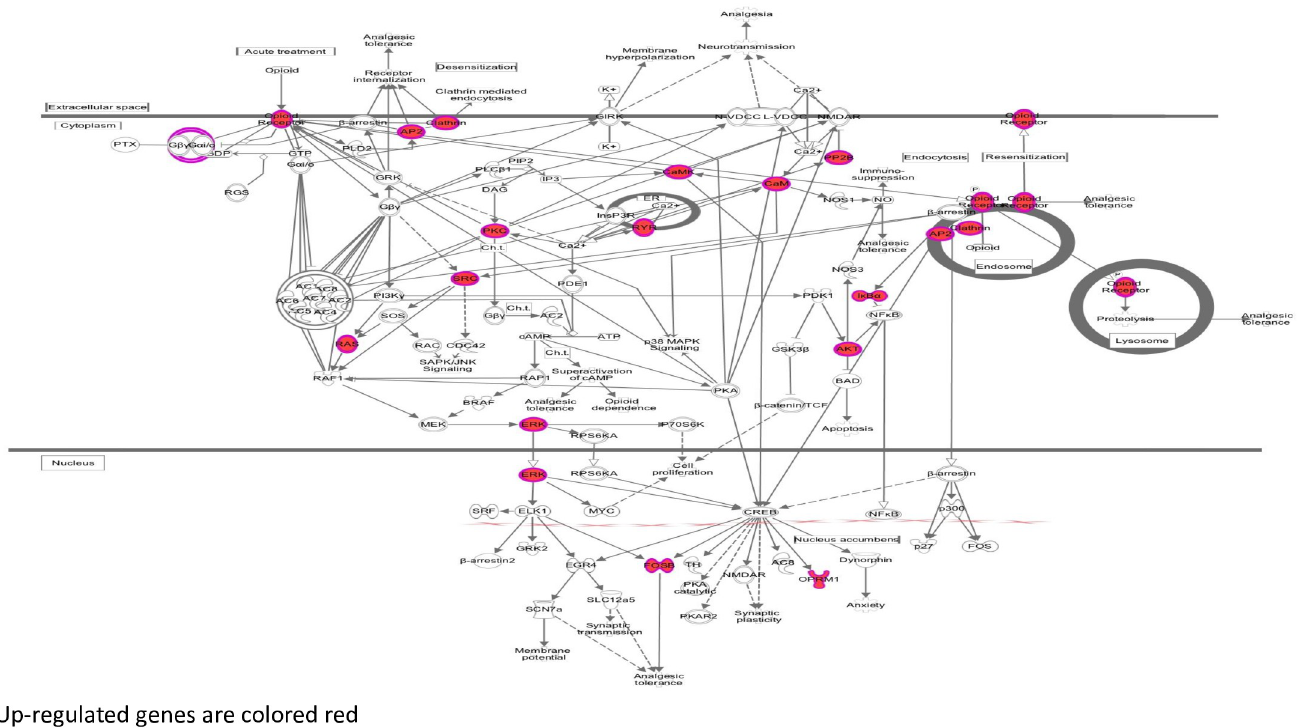
Fig 4. Opioid signaling pathway: Males 7-week green module. Red fill indicates genes positively correlated with lesion burden.